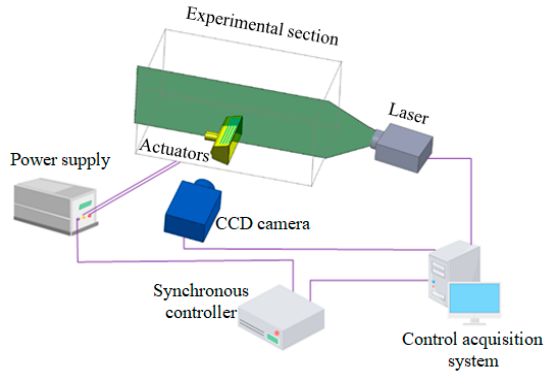
Figure 4. Particle-image-velocimetry system.